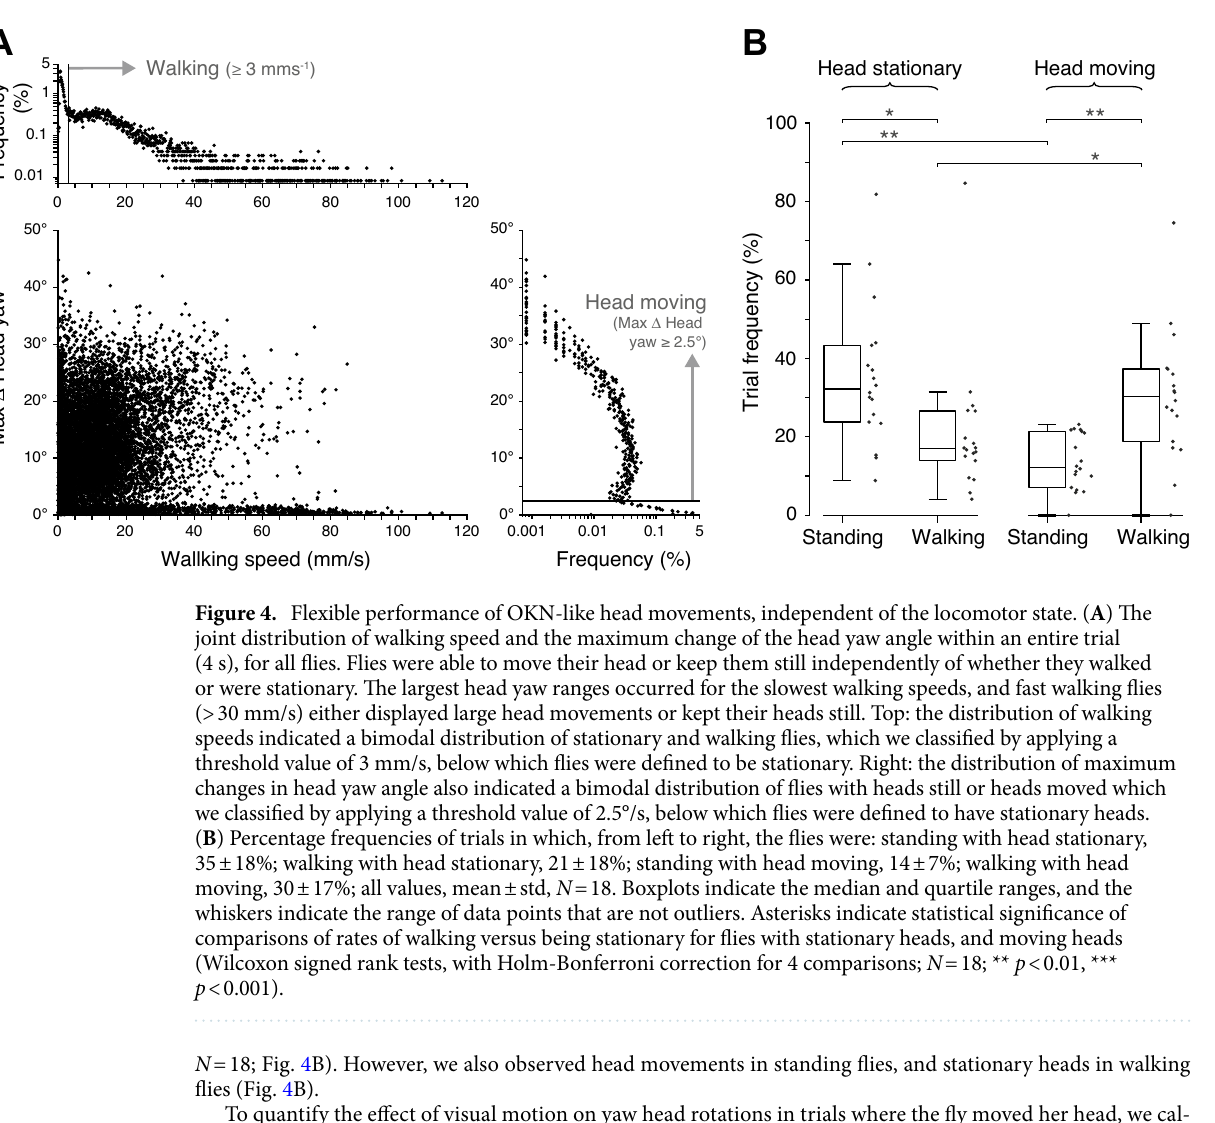
During the yaw rotation stimulus period, the optokinetic index of walking flies varied with the tempo- ral frequency of the moving grating, reaching a peak between 4 and 10 Hz and decreased at higher temporal frequencies (Fig. 5A). When a grey screen was shown in the pre-stimulus period (Fig. 5A, Left), the response to a yaw rotation stimulus presented at 0.25 Hz contrast frequency was low, and the peak response was an OKI of 13.5 ± 2.1°/s to a 7 Hz grating, decreasing to 3.6 ± 1.9°/s for 25 Hz motion. The OKI temporal frequency tuning curves are broadly consistent with the temporal frequency tuning of visual interneurons responding to wide- field horizontal motion. For example, in response to comparable stimuli the H2 LPTC has a peak response at a temporal frequency of 5 Hz, and a sustained non-zero response to 25 Hz gratings in walking flies 44 . During the pre-stimulus progressive motion period, there was a near-zero optokinetic index, with a small bias between 0.7 and 1.7°/s (mean values for 0 Hz and 10 Hz pre-stimulus conditions, respectively) that was not significantly dif- ferent from zero except for the 10 Hz pre-stimulus condition ( p = 0.01, t -test with Holm-Bonferroni correction for multiple comparisons, N = 18; Fig. 5B). The mean walking speed of the trials varied with the temporal frequency of the pre-stimulus progressive visual motion (Fig. 5C). Flies viewing a grey screen or stationary grating in the pre-stimulus period respectively walked with a forward velocity of 11.2 ± 1.3 and 14.4 ± 1.2 mm/s during the rotation stimulus (mean ± S.E.M.;